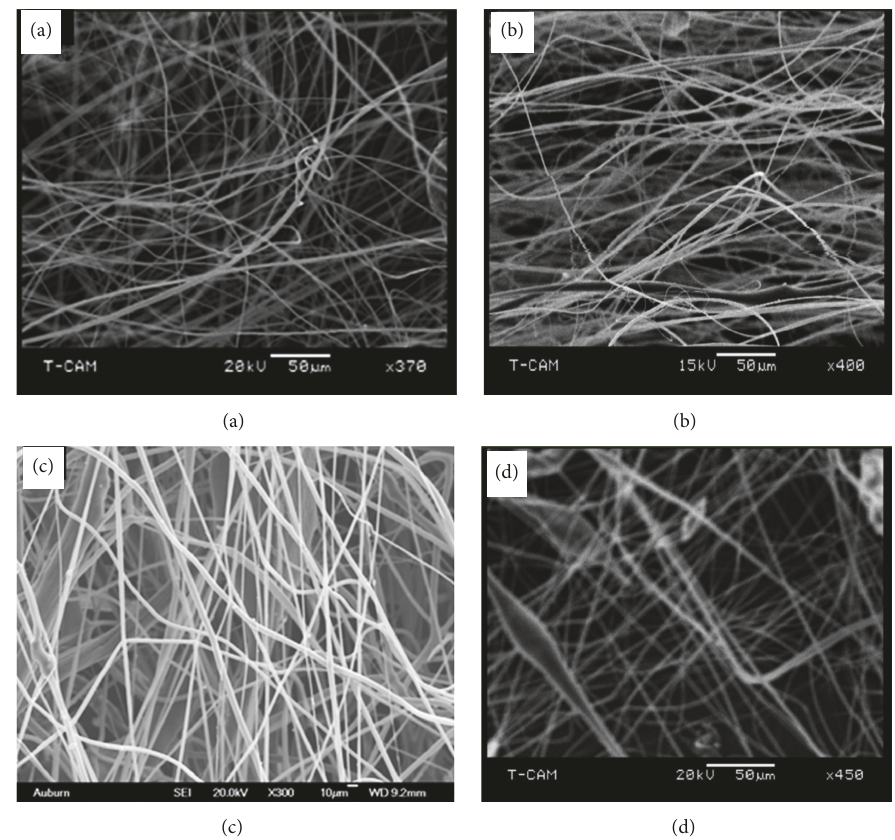
Figure 3: Low magnification SEM images of (a) pristine PLA, (b) PLA/EnHA, (c) PLA/2.5wt% EnHA5wt%, and (d) PLA/EnHAwt% electrospun